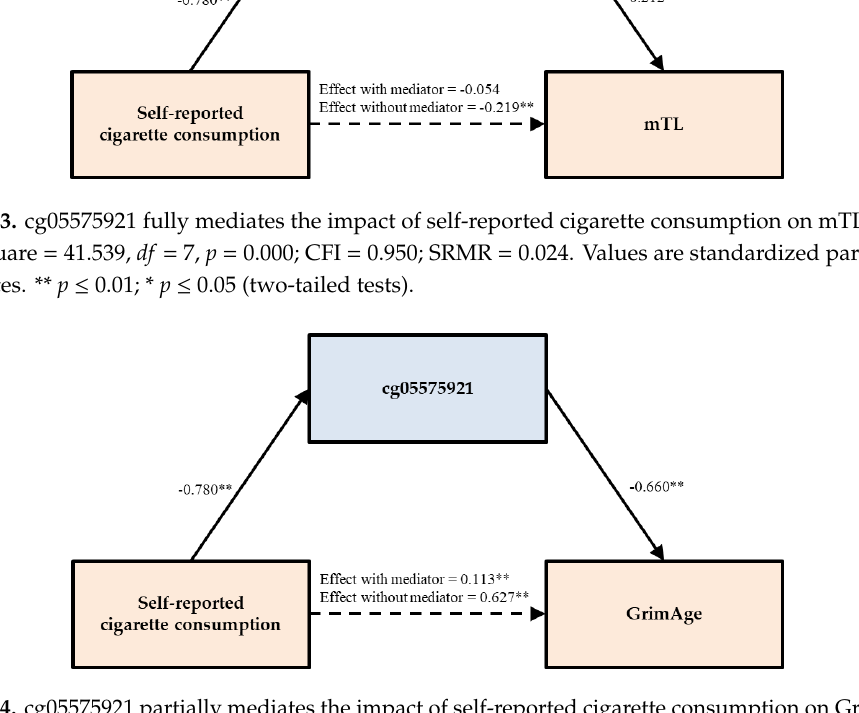
Figure 4. cg05575921 partially mediates the impact of self-reported cigarette consumption on GrimAge. Note. Chi-square = 41.539, df = 7, p = 0.000; CFI = 0.968; SRMR = 0.028. Values are standardized parameter estimates. ** p ≤ 0.01; * p ≤ 0.05 (two-tailed